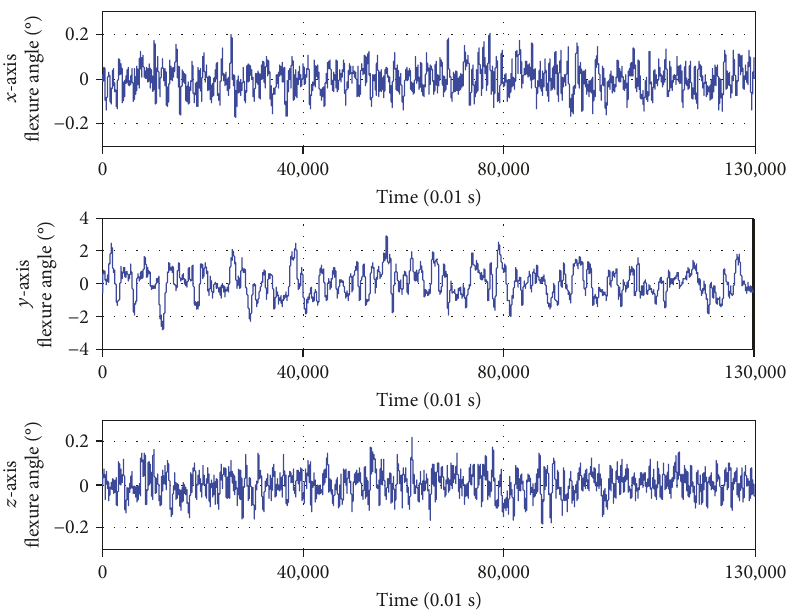
Figure 5: Flexure angle on x -axis, y -axis, and z